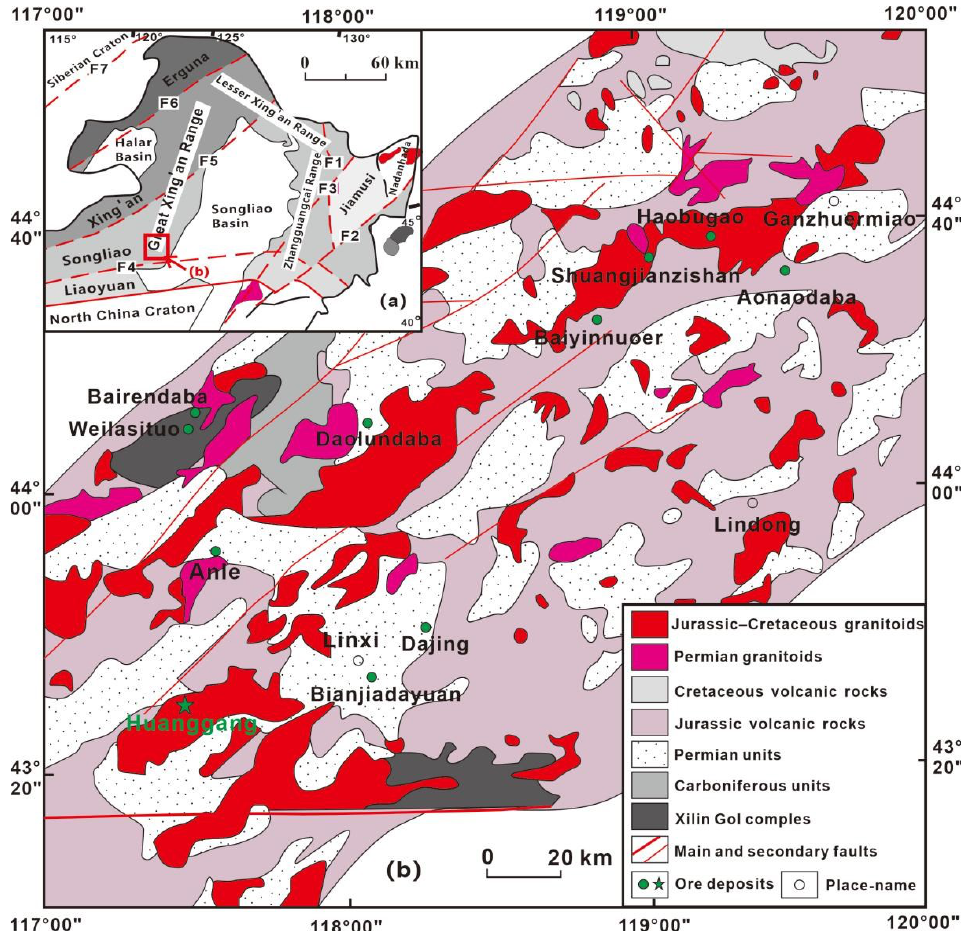
Figure 1. ( a ) Tectonic subdivisions of NE China; ( b ) Regional geological map of the Southern Great Xing’an Range (a is after Wu et al., 2011 [ 30], b is after Liu et al., 2016 [31]). F1 — Mudanjiang fault;